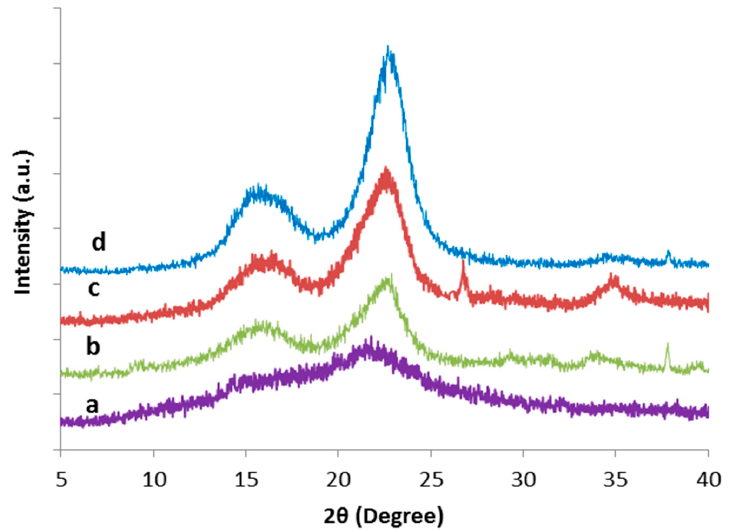
Figure 3. XRD diffractograms of (a) raw TLWF; (b) alkaline-treated TLWF; (c) bleached TLWF and; (d) CNC. Table 2. Crystallinity index of TLWF at different stages of treatments.